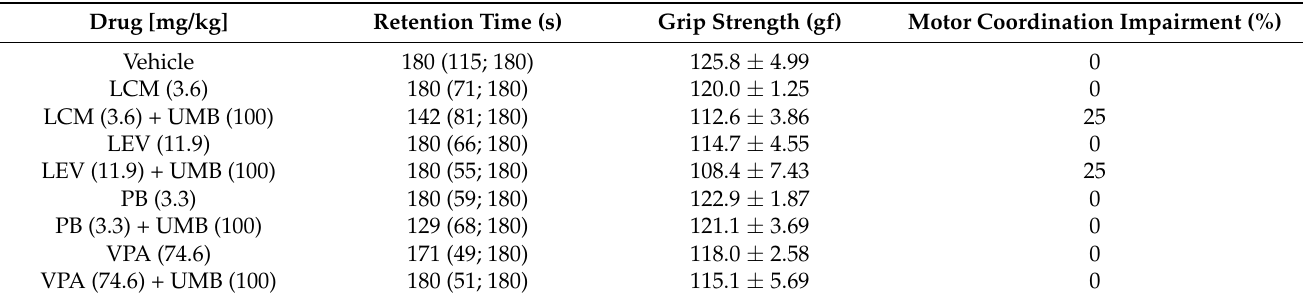
Table 1. Effects of UMB and its combinations with varipus anti-seizure medications on long-term memory, muscular strength and motor performance in